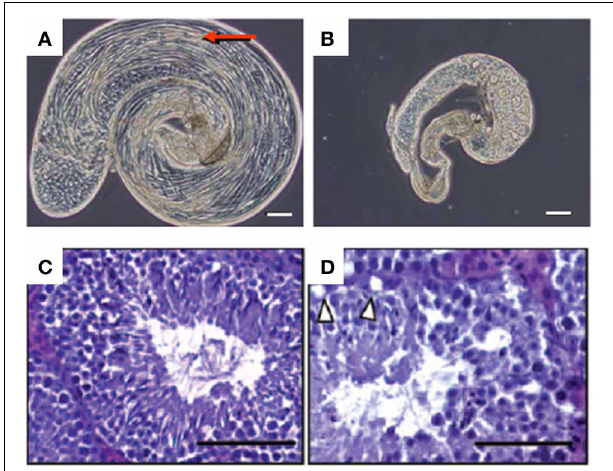
FIGURE 6 | Male fertility problems in peroxisome deficient animals. (A,B) Phase-contrast micrographs of testes of fruitflies, with bundles of elongated spermatids (arrow) in a wild type (A) and arrest of germline cell maturation in a pex16 1 homozygous fruitfly (B) . Bar, 100 μ m. Taken from Nakayama et al. (2011). (C,D) Hematoxylin-eosin staining of 7 weeks old testis of wild type (C) and Sertoli PEX5 knockout mice (D) , the latter showing lipid droplets that were emptied during the embedding procedure in the outer layer of the seminiferous epithelium (arrowheads) and reduced numbers of spermatozoa in the lumen of the tubuli. Bar 100 μ m. Taken from Huyghe et al.